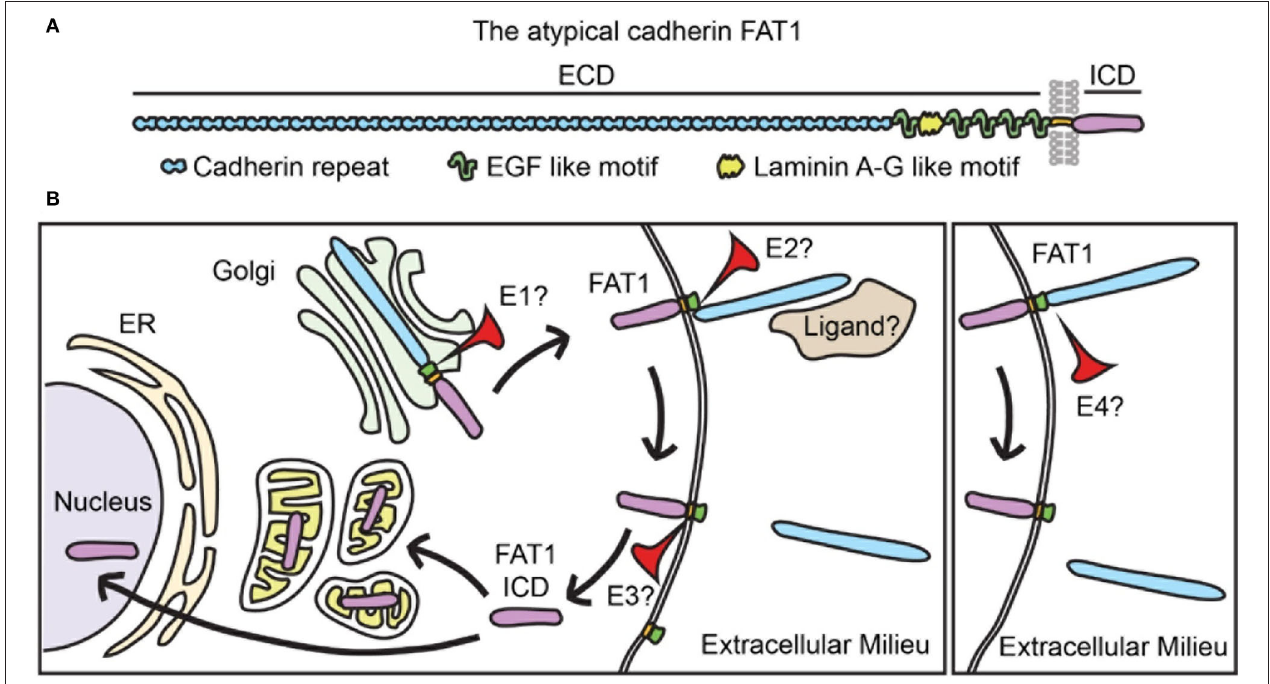
FIGURE 1 | FAT1 is a transmembrane protein that undergoes complex processing. (A) FAT1 structure showing its large extracellular domain (ECD) bearing 34 cadherin repeats, 5 EGF-like motifs, and one laminin A-G motif. FAT1 also has a single transmembrane spanning domain and an intracellular domain (ICD). EGF, epidermal growth factor. ( B ) In vascular SMCs the FAT1 ICD has been found in mitochondria and nuclei, suggesting that FAT1 undergoes proteolytic processing that releases the ICD. Studies of FAT1 in cancer biology propose two processing pathways: classical (left panel) and alternative (right panel). The classical pathway involves three sequential proteolytic events: 1) furin-mediated cleavage that occurs in the secretory pathway and results in expression of a heterodimer on the membrane, 2) a disintegrin and metalloproteinase (ADAM)-mediated cleavage of the ECD that results in ectodomain shedding, and 3) a γ -secretase complex-mediated cleavage in the transmembrane region that releases the ICD. In the alternative pathway, intact full-length FAT1 is expressed on the plasma membrane and cleaved in its extracellular domain by an unknown protease. Proteolytic processing has not been formally studied in vascular SMCs, thus whether FAT1 follows classical or alternative proteolytic processing (or both), and the identity of the proteolytic enzymes involved (E1, E2, E3, and E4) remain unknown. Whether FAT1 cleavage is regulated by ligand binding is also an open question (see also refs (30,